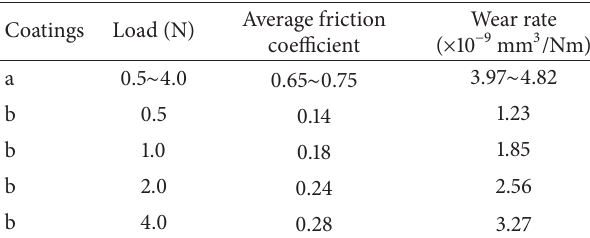
Table 1: Comparison of friction and wear properties of two different coatings at different